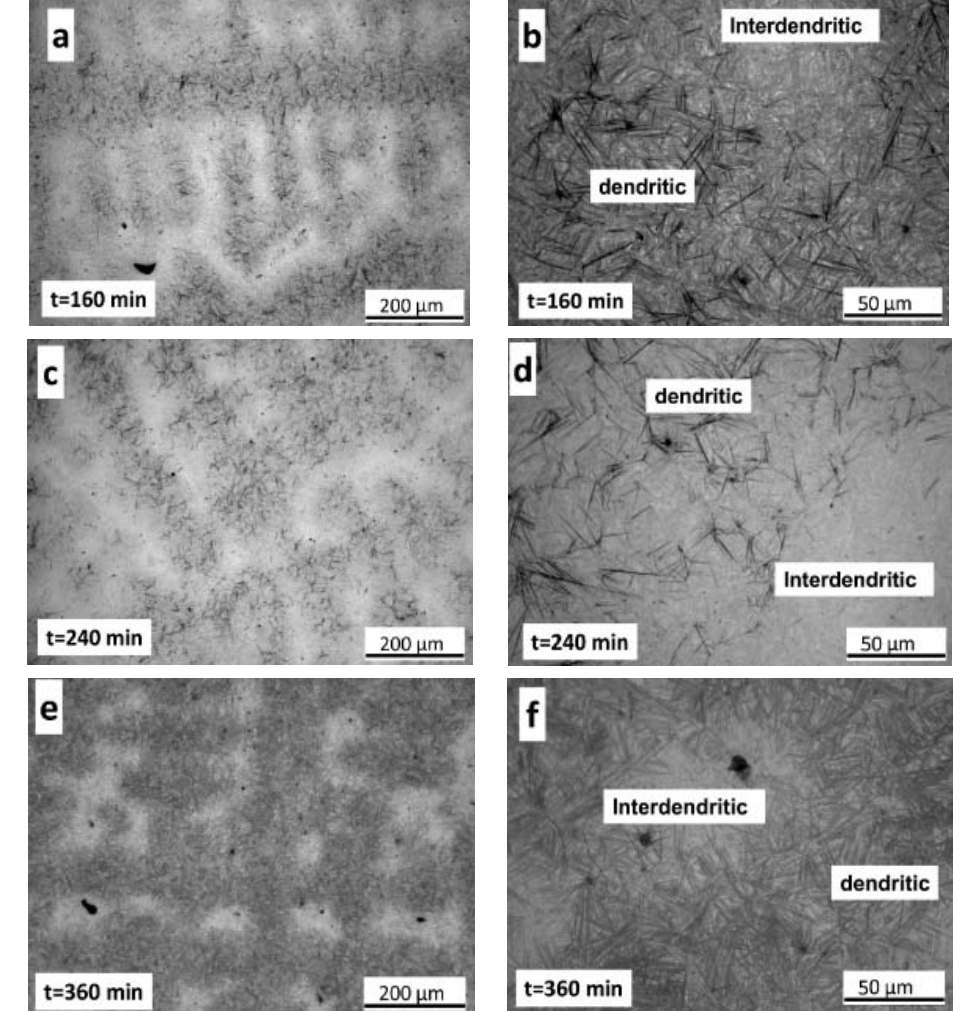
Figure 14. LOM micrographs corresponding to a sample austempered at 230 °C for 160 ( a,b ), 240 ( c , d ) and 360 ( e , f ) min. Microstructures etched with Nital 2%. and 360 ( e , f ) min. Microstructures etched with Nital